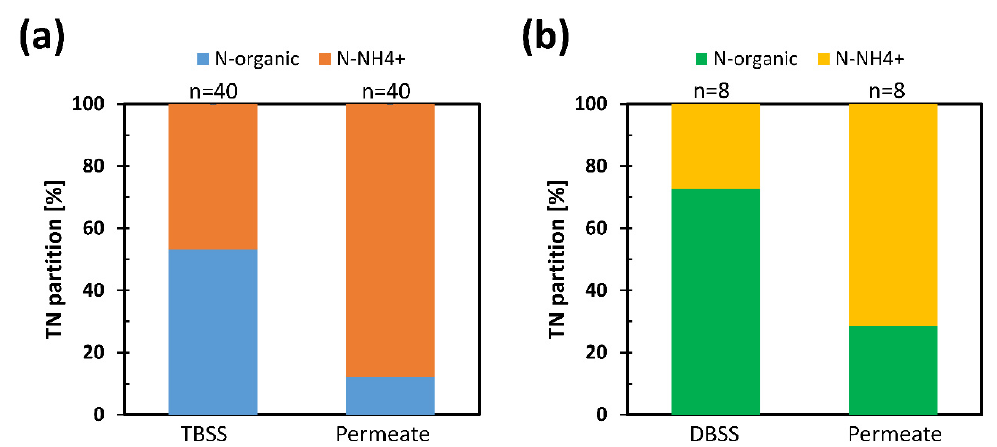
Figure 3. TN partition ( a ) in TBSS and ( b ) in DBSS. TN: total nitrogen, TBSS: thickened biological sewage sludge, DBSS: digested biological sewage sludge, n: number of